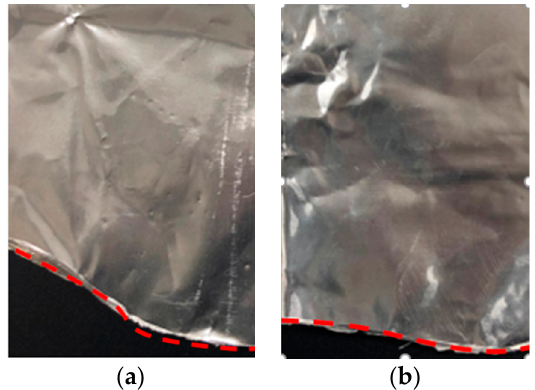
Figure 15. The shapes of the pure aluminum foil melted in the 7075 alloy melt: ( a ) without electromagnetic shielding ring; ( b ) with electromagnetic shielding ring.